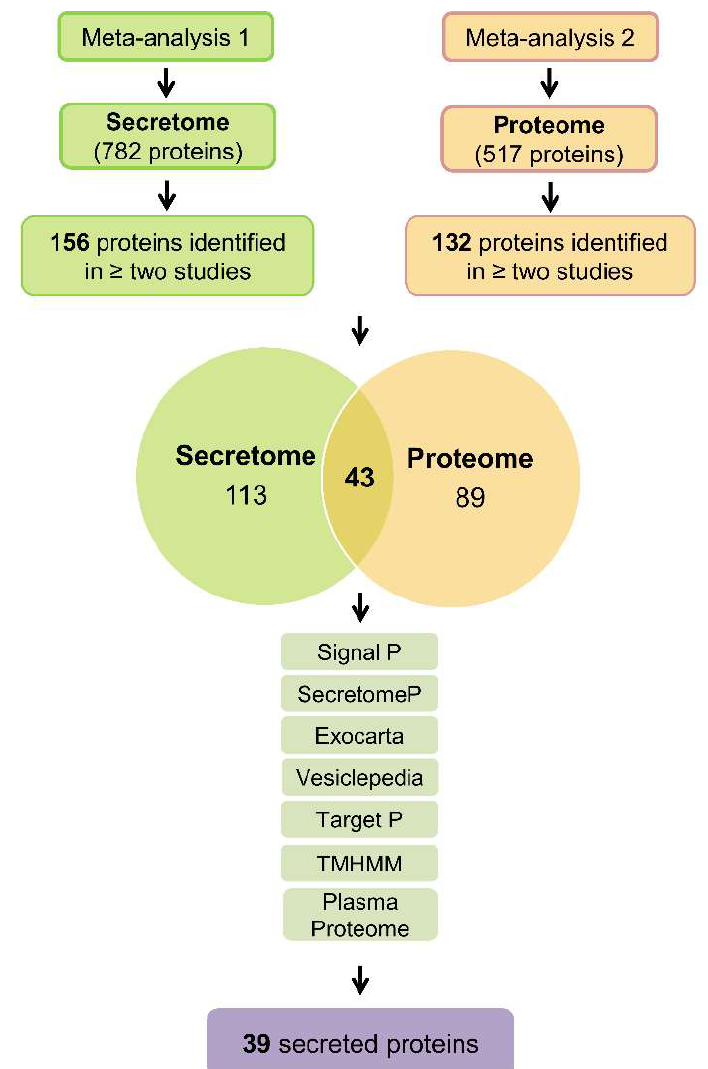
Figure 2. Schematic representation of the workflow used to identify secreted proteins in pancreatic cancer studies. Two meta-analyses of publicly available proteomic studies were used to identify secreted proteins in pancreatic ductal adenocarcinomas: meta-analysis 1 identified 782 proteins in the secretome, and meta-analysis 2 identified 517 proteins in the proteome. Subsequently, the proteins present in two or more studies were selected. This strategy resulted in a final list containing 156 proteins in the secretome (meta-analysis 1) and 132 proteins in the proteome (meta-analysis 2). The intersection between the proteins identified 43 shared proteins between the two meta-analyses. These 43 proteins were further verified as secreted using the algorithms available at Center for Biological Sequencing Analysis (CBS): SignalP [97] (identifies classical secreted proteins, presence of signal peptide); SecretomeP [98] (identifies non-classical secreted proteins); and the databases Vesiclepedia [99] (protein data in secretory vesicles), ExoCarta [100] (protein data in exosomes) and Plasma Proteome [101] (protein data identified in the blood). Proteins were excluded from further analysis if detected by the CBS TargetP [102] (mitochondrial protein) or TMHMM [103] (transmembrane helix protein) algorithms, resulting in a final list of 39 proteins in the pancreatic ductal adenocarcinoma shared by proteome and secretome studies.